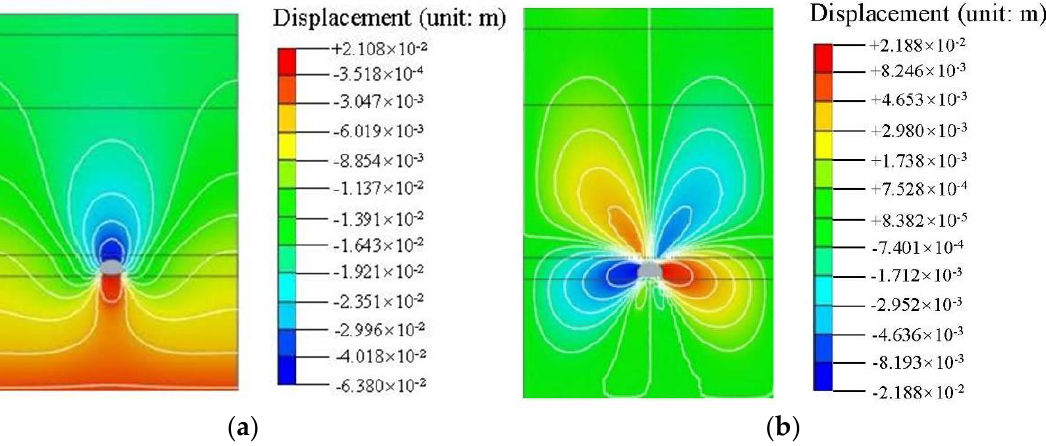
Figure 16. Maps of surrounding rock deformation: ( a ) vault settlement; ( b ) horizontal convergence. Table 2. Displacement comparison of monitoring points.